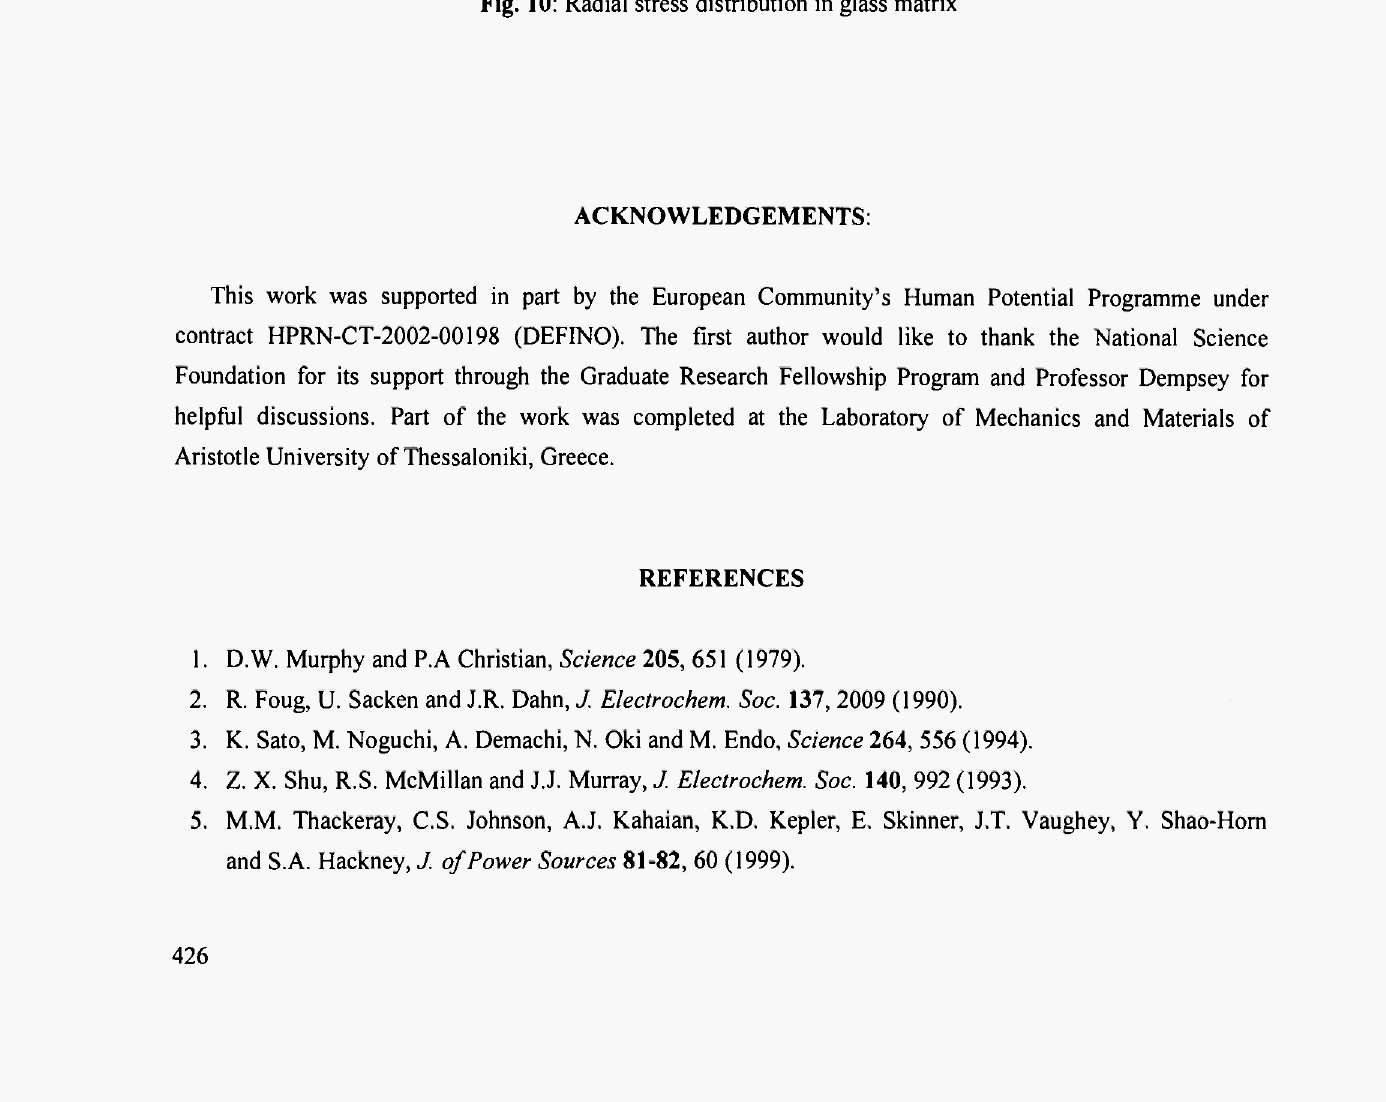
Fig. 10: Radial stress distribution in glass